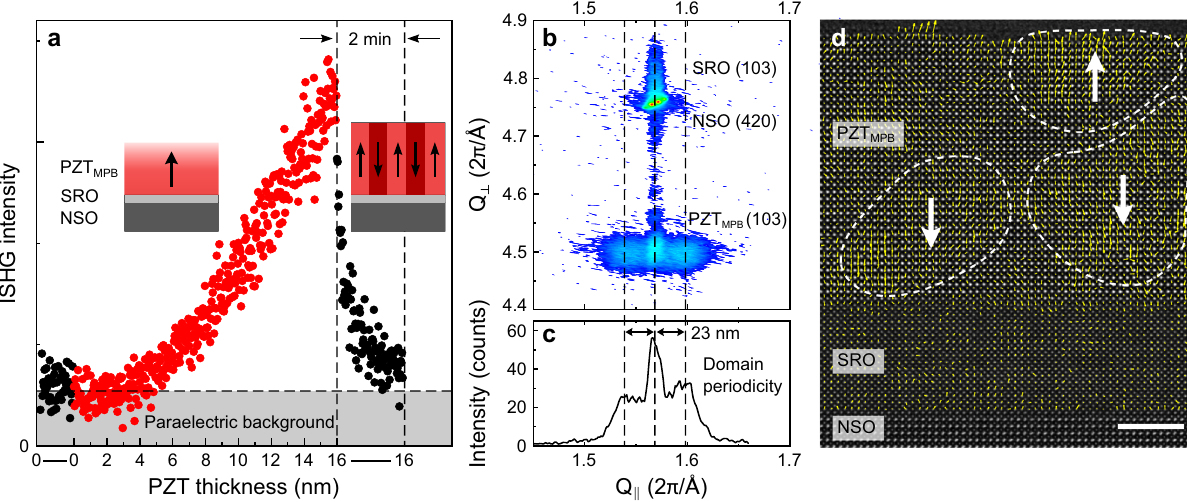
Fig. 1 Formation of nanoscale 180° domains in strained PZT MPB thin fi lms. a ISHG signal evolution during the ongoing growth of PZT MPB on SRO-buffered NSO (red symbols) and at halted growth (black symbols). The insets illustrate the prevailing domain con fi gurations during and after growth. b Reciprocal space map (out-of plane Q ⊥ vs. in-plane Q || ) around NSO 420 and PZT MPB 103. The PZT MPB fi lm is fully strained with an extracted tetragonality c / a of 1.04. The dashed vertical lines indicate the main peak and satellite peak positions. c Cross-section at fi xed Q ⊥ across the intensity distribution around the PZT MPB 103 re fl ection. d HAADF-STEM image with overlaid ferroelectric dipole map viewed along the [010] zone axis. The yellow arrows reveal the presence of oppositely polarized 180° domains delimited by the dashed white lines. The white arrows represent the net polarization of each nanodomain. Scale bar,